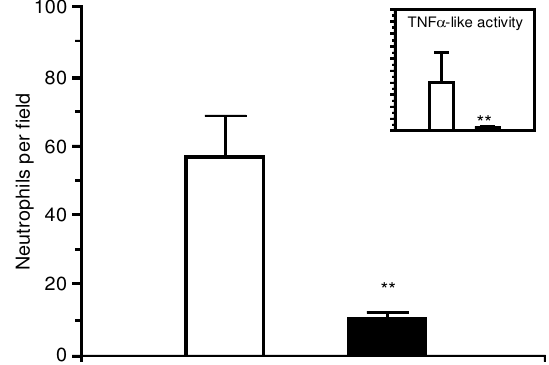
FIG. 7. Effects of liposome-encapsulated clodronate on neutrophil recruitment and the TNF- a like activity triggered by LPS in Brown Norway rat air pouches. Liposome- encapsulated clodronate and empty liposomes were admin- istered under a volume of 0.3 ml into the 7-day-old air pouches, 96 h before LPS (200 ng, 2 h). Results are ex- pressed as mean SEM of number of neutrophils per ® eld ( n = 6) and of the TNF- a like activity recovered in the air pouch washing supernatants ( n = 6) (inset). Comparison was performed for liposome-encapsulated clodronate ( j ) vs. empty liposome ( h ) ( P , 0.01; P ,